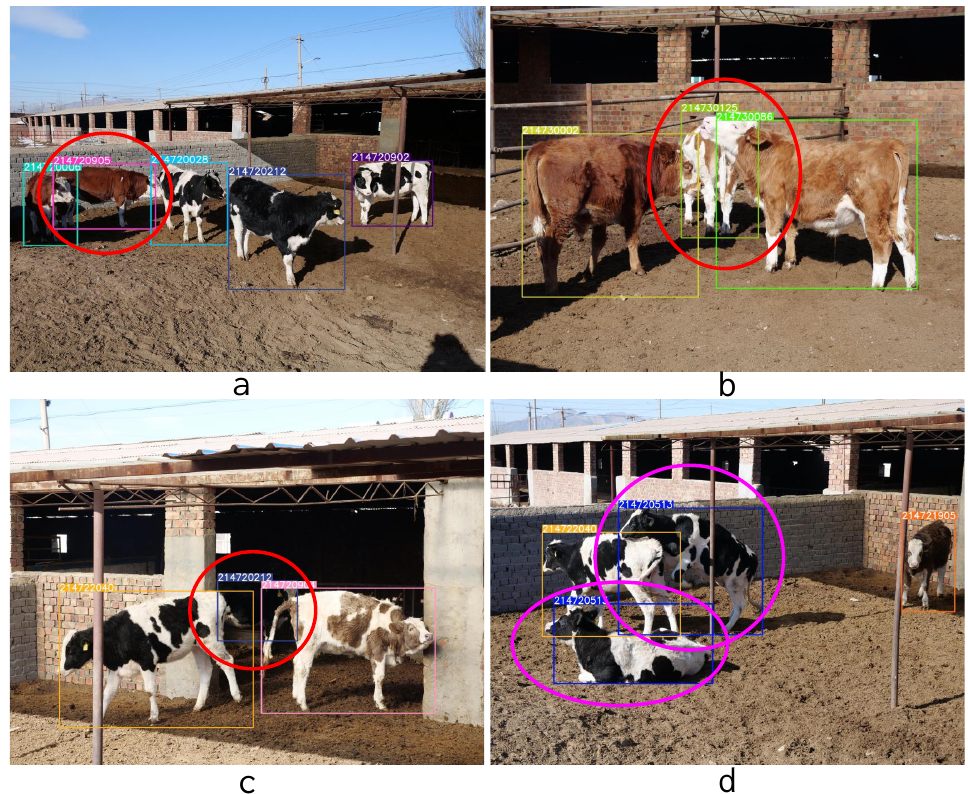
Figure 10. Engineering application results. It is shown that our proposed approach has the ability to generalize to new breeds and more realistic and complicated scenarios. It correctly identified instances obstructed by farming structures or other animals (the targets circled in red in ( a – c )). It also correctly recognized the breeds that had diverse postures (the targets circled in pink in ( d )). Best viewed in color.